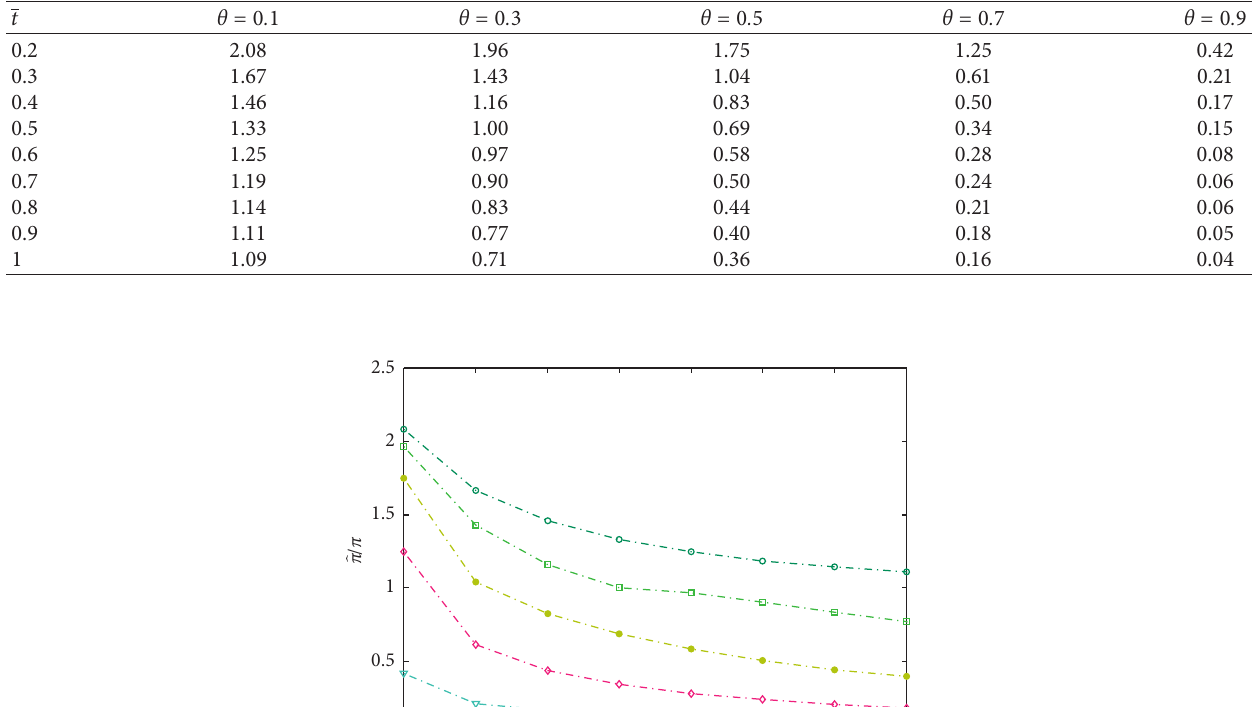
Table 4: The profit ratio 􏽢 π / π given δ � 0 . 4 and s � 0 . 3.